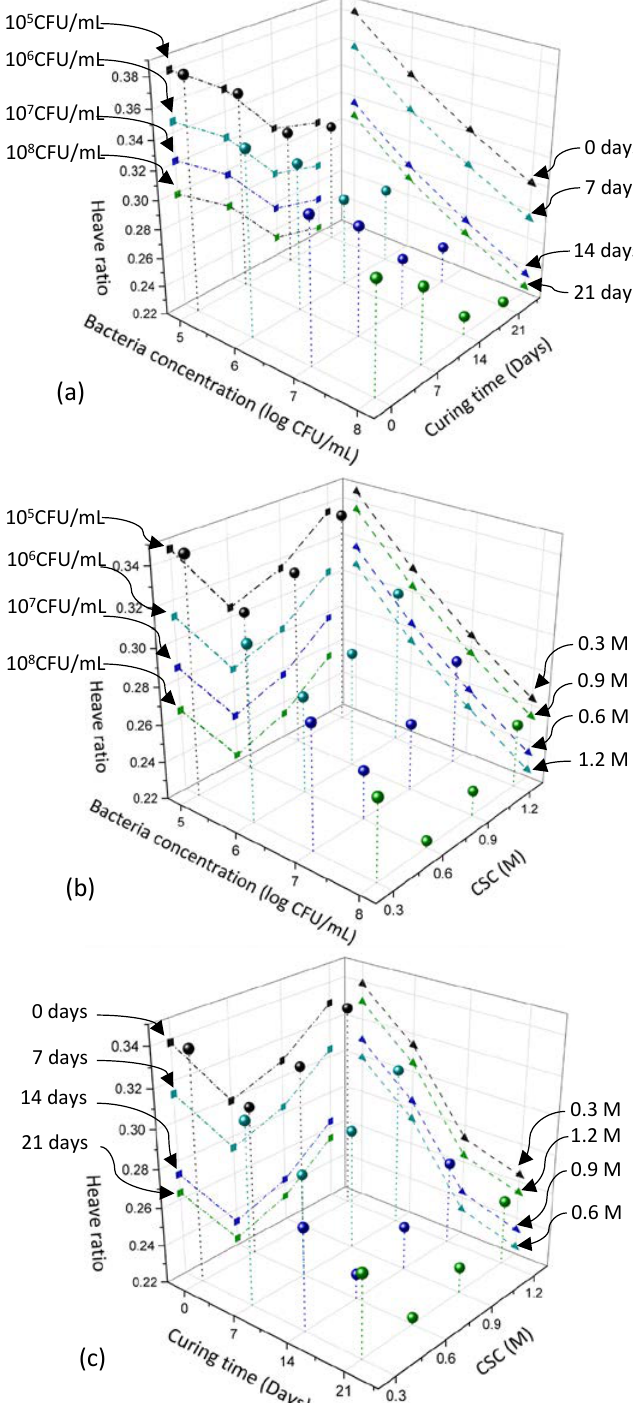
Fig. 6: Diagrams of heave ratios at 0.6 M CSC (a), 21 days curing time (b) and 10 8 CFU/mL bacteria concentration